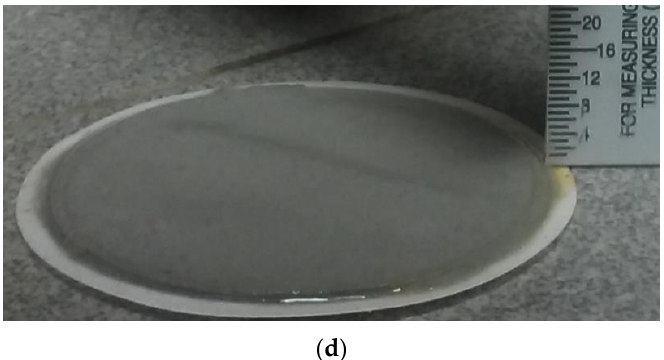
Figure 6. Fluid loss measurement of water-based muds with 5% error bar. ( a ) Fluid loss measurements, ( b ) Fluid loss percent reduction when graphene nanoplatelet and nanosilver are present, ( c ) Filtrate collected from the HPHT filter press, and ( d ) Mud filter cake produced at 500 psi.